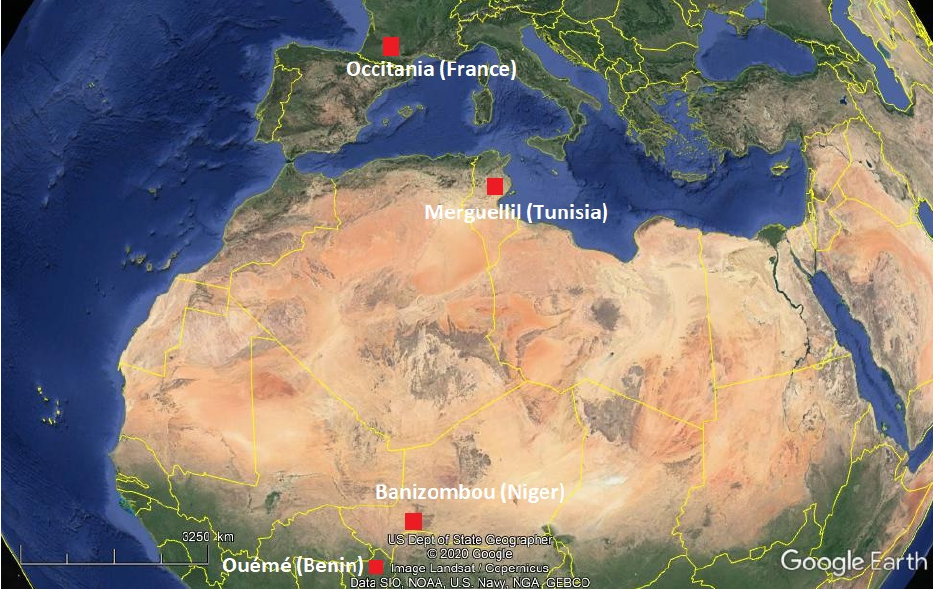
Figure 1. Studied areas (Occitania, Merguellil, Banizombou, and Ouémé).